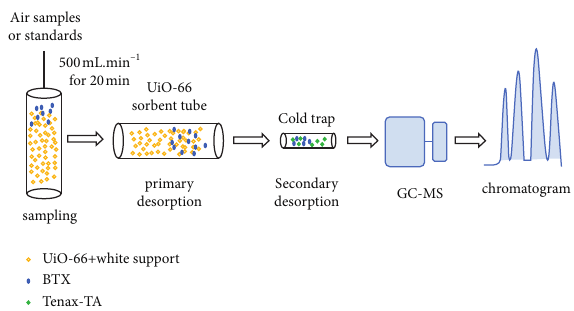
Figure 1: Scheme of analytical procedure on the UiO-66 sorbent